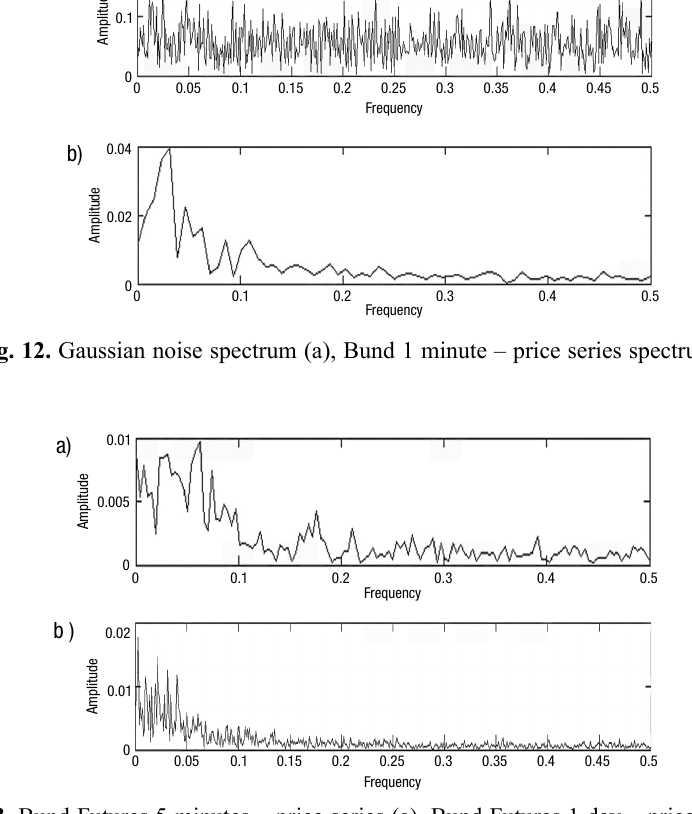
Fig. 13. Bund Futures 5 minutes – price series (a), Bund Futures 1 day – price series